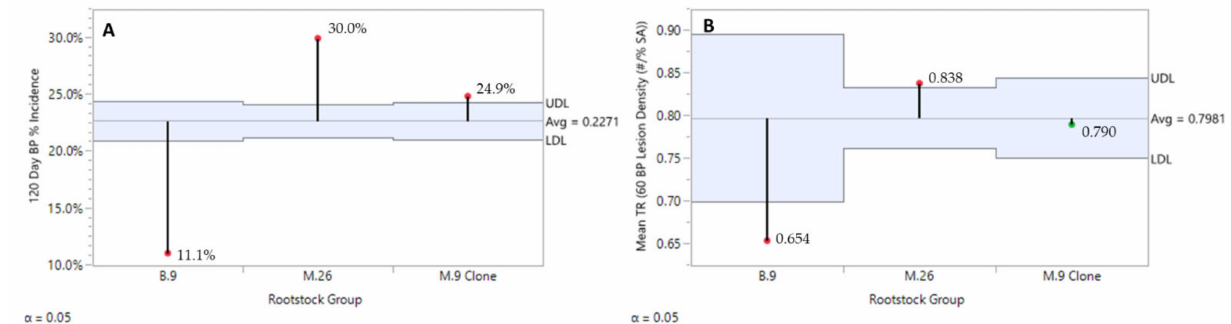
Figure 3. Rootstock effect on ‘Honeycrisp’ bitter pit incidence ( A ) and on ‘Honeycrisp’ bitter pit severity ( B ) after 120 days of refrigerated storage with all years and both regions combined (A). JMP Fit XY Platform, Analysis of Means of Proportions of the binomial dataset, alpha = 0.05.